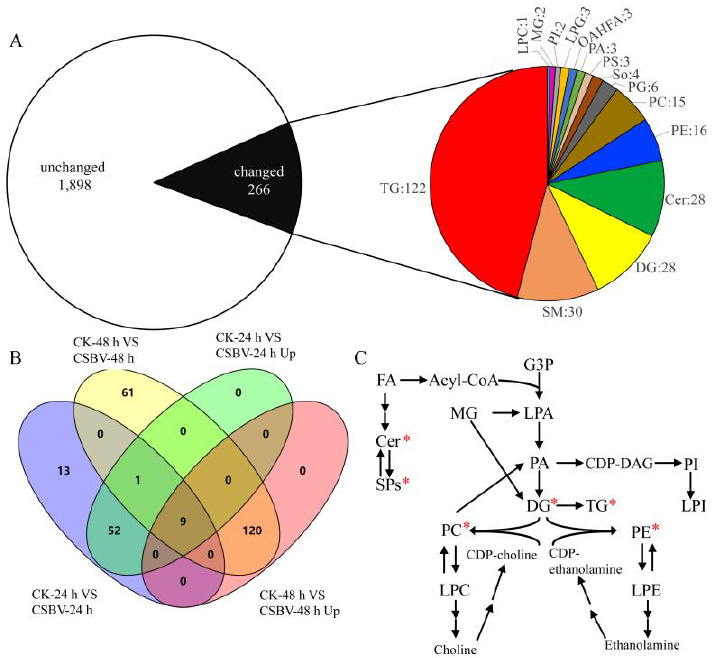
Figure 3. Lipidomics profile of the A. c. cerana larvae during the course of CSBV infection significant changes were observed in the metabolic profile of the larvae upon infection. ( A ) The right pie chart displays the total lipids identified in this study, the left pie chart shows numbers of features in the larvae detected on 24 h and 48 h following a CSBV-infectious compared to the health larvae with significantly altered levels of abundance (|Log2 fold change| > 1 and p -value < 0.05) in black and non-significantly altered levels of abundance (|Log2 fold change| < 1 or p -value > 0.05) in white. The right pie chart displays the distribution of the changed lipids. ( B ) The Venn diagram shows numbers of features that were altered in abundance in CSBV-infected larvae compared to uninfected larvae. ( C ) Overview of lipid classes observed in this study and their relationships to each other within metabolic pathways. Red stars ‘ * ’ indicate that the lipids were significantly changed in lipid levels.